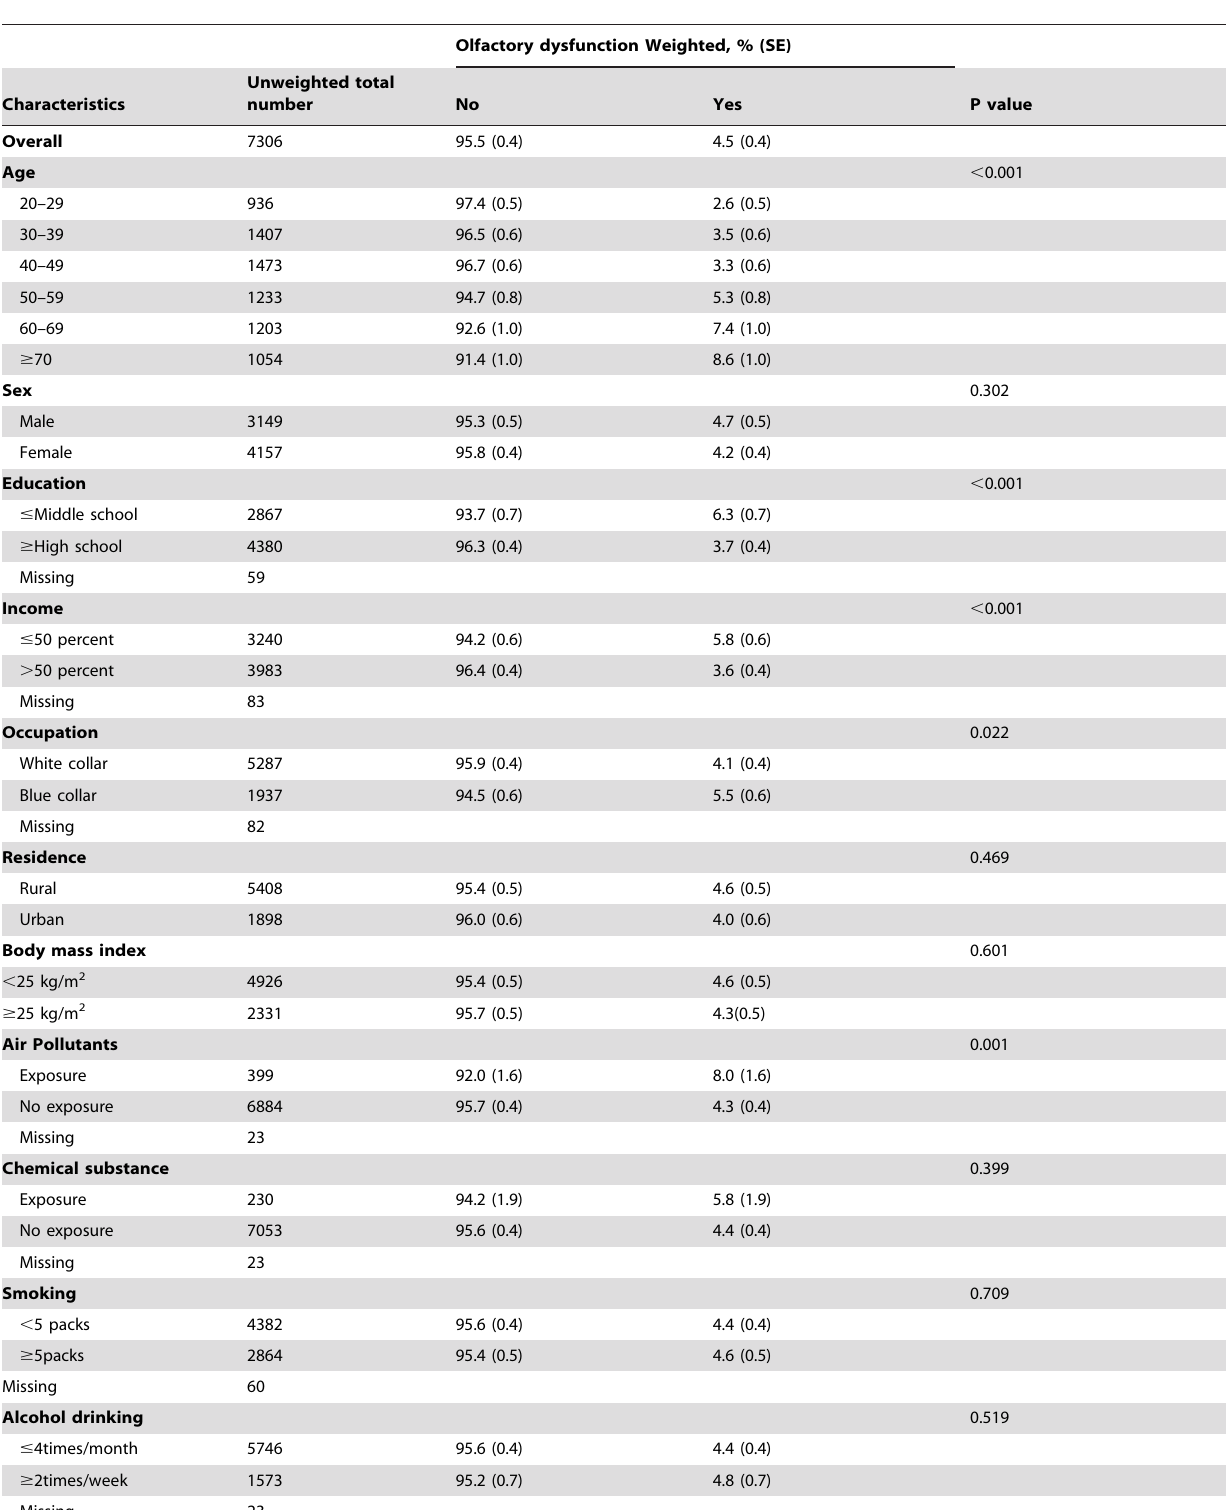
Table 1. Prevalence of olfactory dysfunction according to the general characteristics of KNHNES participants according to the presence of olfactory dysfunction (weighted for the multistage sampling design of KNHANES